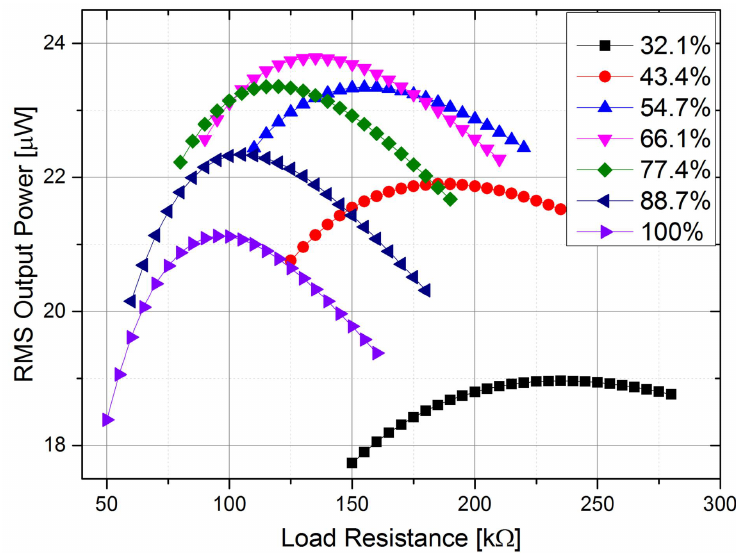
Figure 4. RMS output power versus load resistance for harvesters with different electrode coverage ratios.